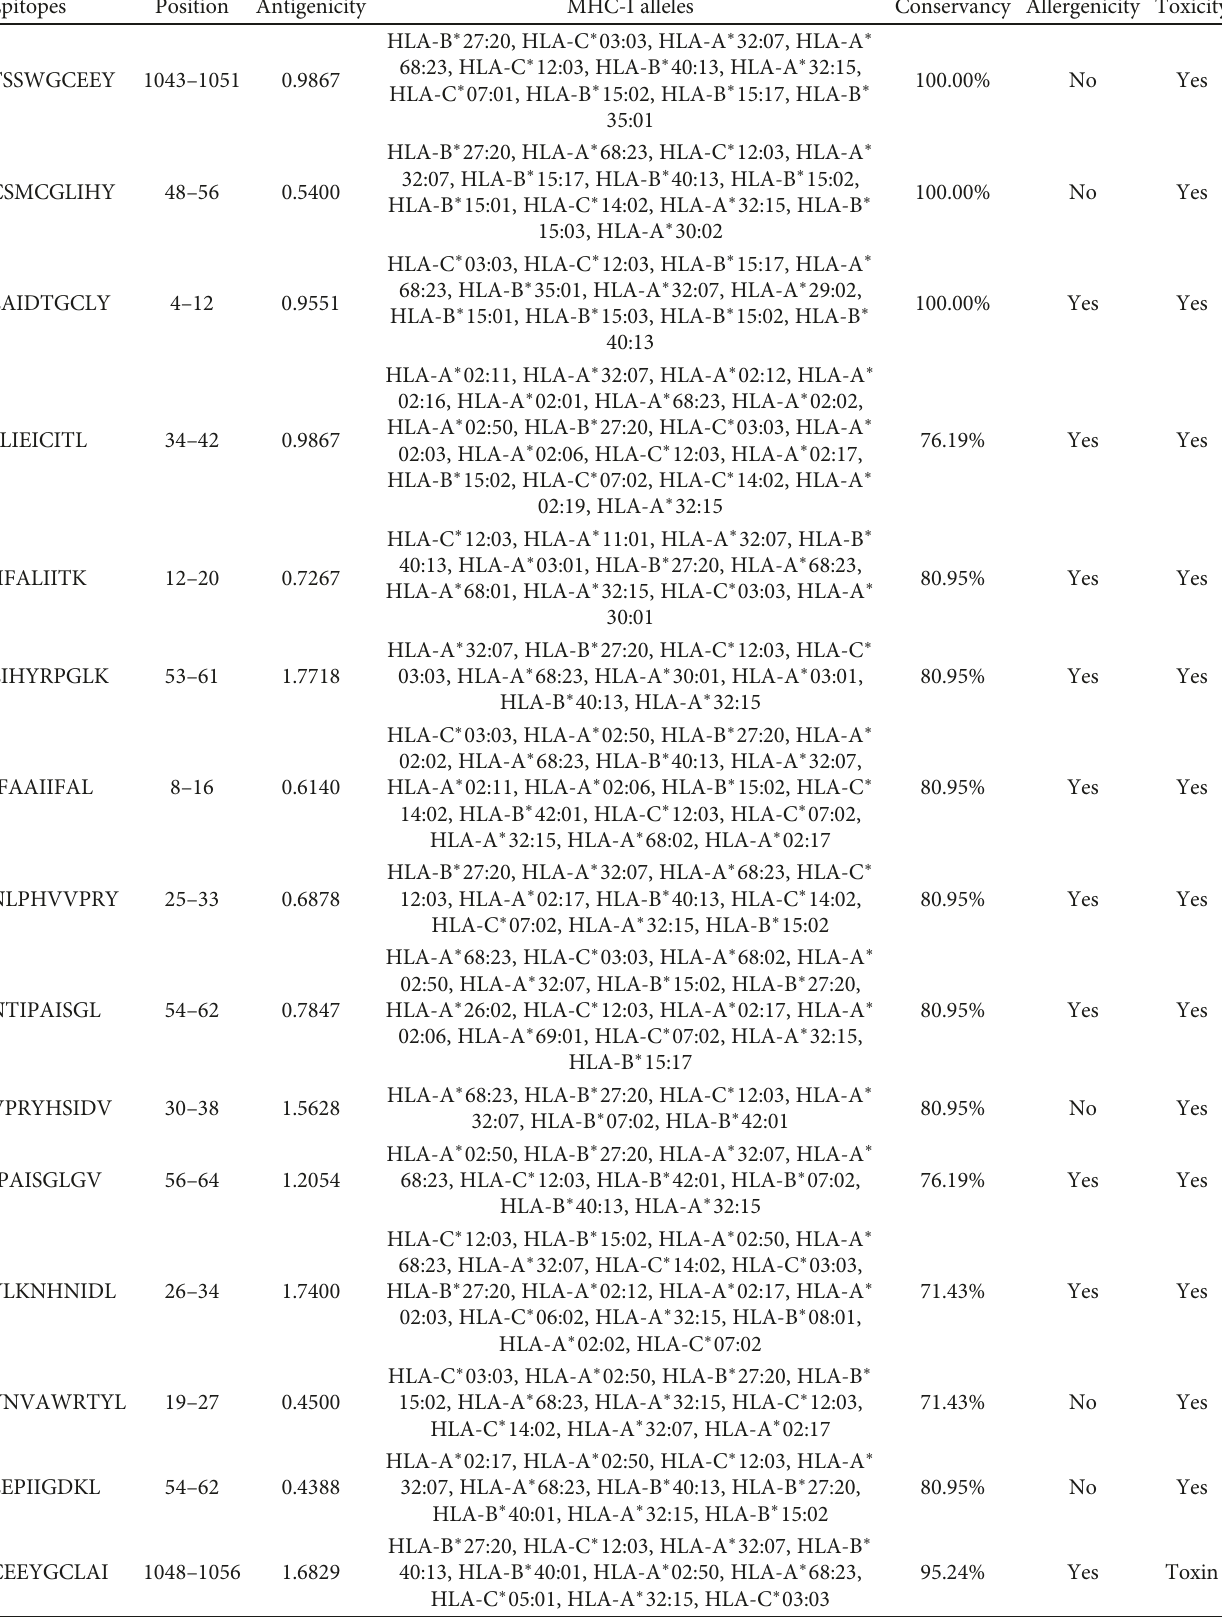
Table 1: Most potential 18 T-cell epitopes with interacting MHC-I alleles, epitope conservancy score, allergenicity, and